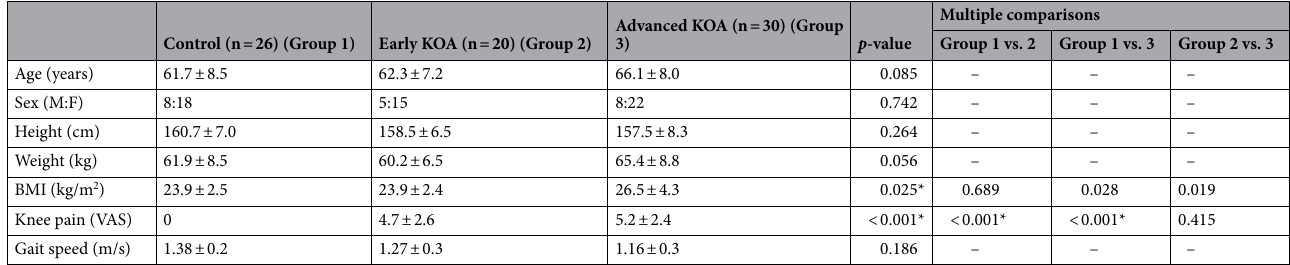
Table 1. Demographic, anthropometric, and clinical data for the three groups. Values are mean ± standard deviation or n. P -value by Kruskal–Wallis test and Fisher’s exact test. Multiple statistical differences between groups by Mann–Whitney U test with Bonferroni correction. KOA knee osteoarthritis, M male, F female, BMI body mass index, VAS Visual Analogue Scale. *Significant difference between groups.